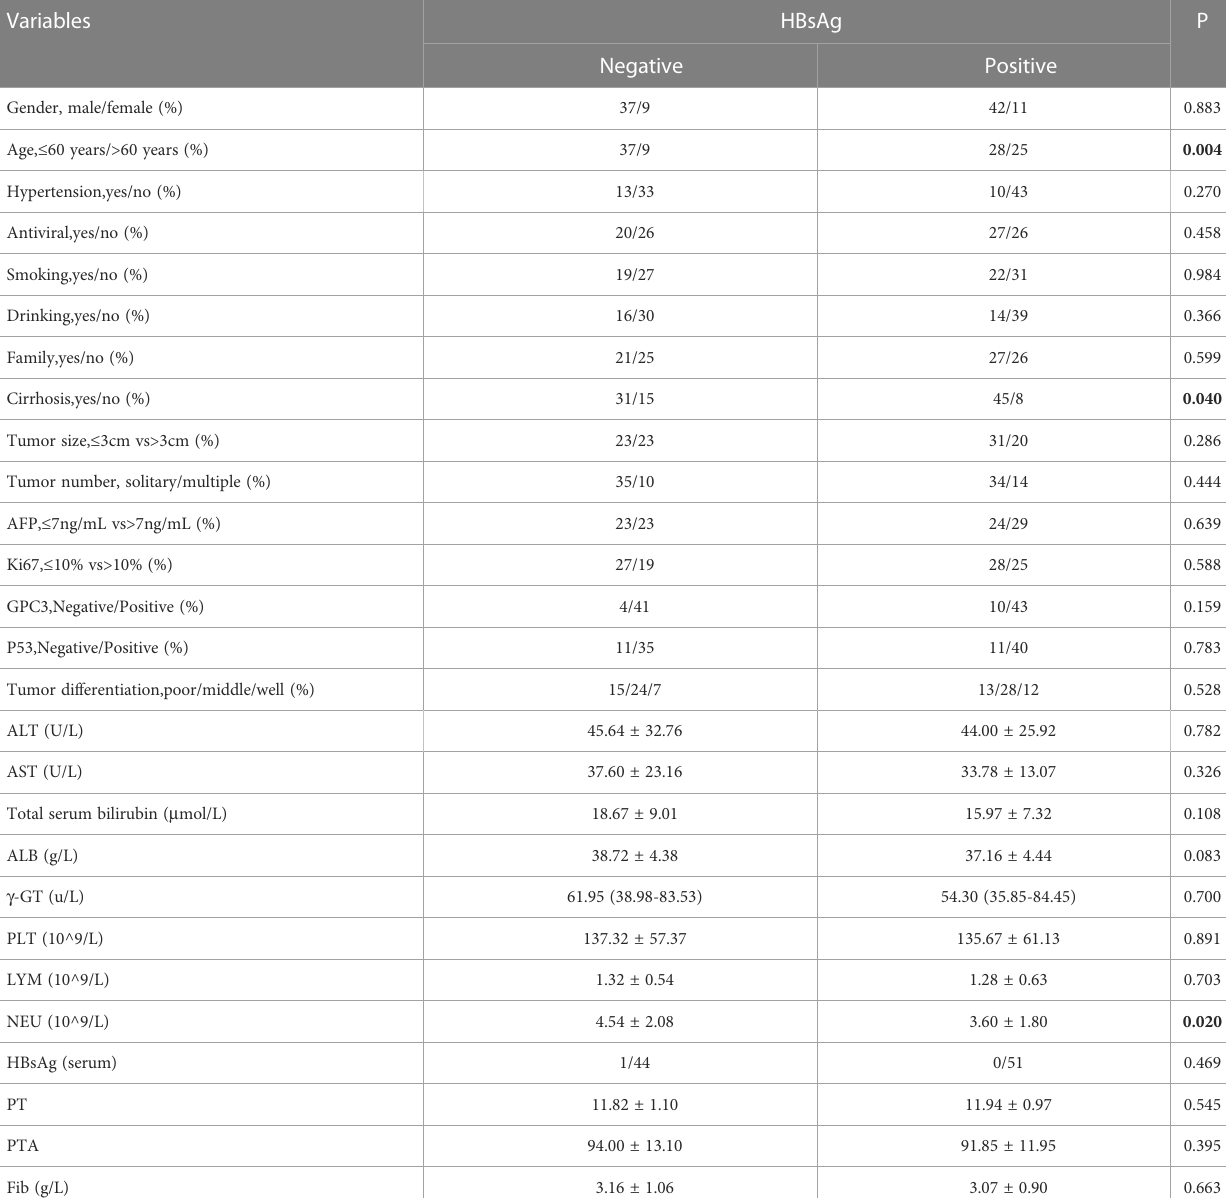
TABLE 4 Comparison of clinical data based on intrahepatic